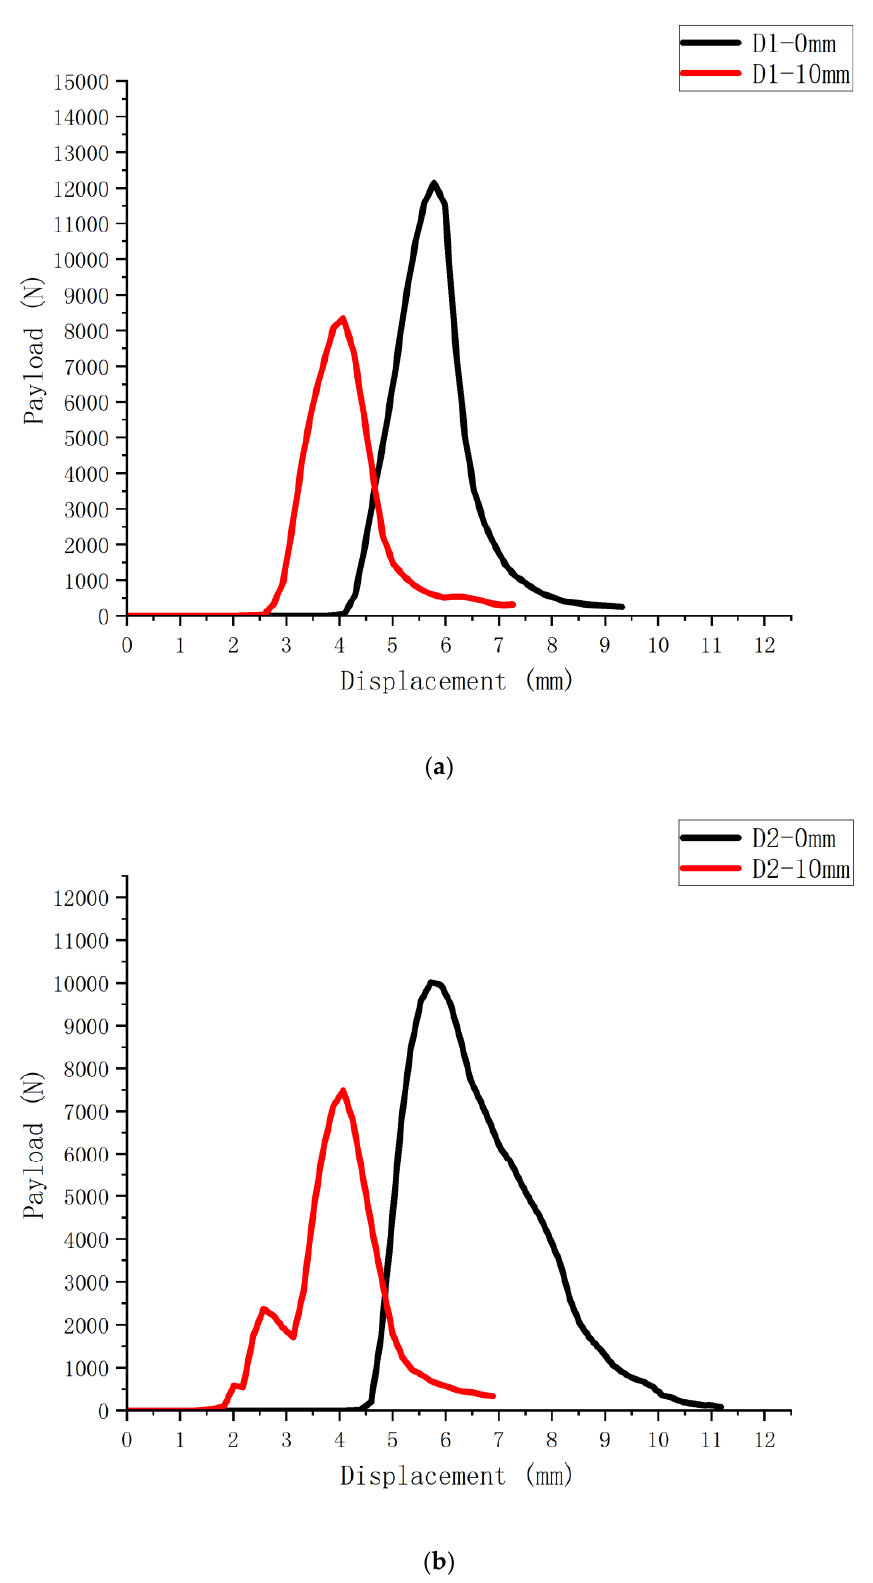
Figure 3. Load-displacement curves of short-term aged asphalt mixture SCB specimens: ( a ) D1 asphalt mixture SCB test curve; ( b ) D2 asphalt mixture SCB test curve.